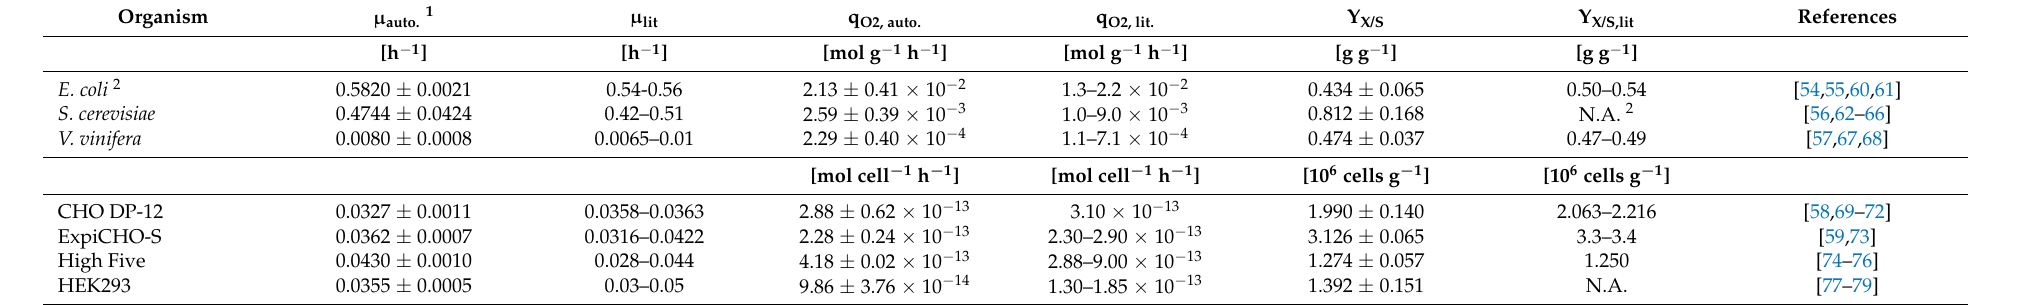
Table 4. Comparison of automatically determined growth rates, specific oxygen uptake rates and biomass yield with published reference values. As far as possible, similar/same strains, media and process conditions were considered for the selection of literature